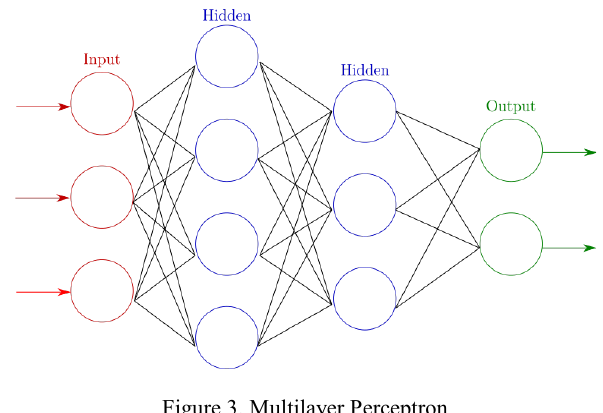
Figure 3. Multilayer